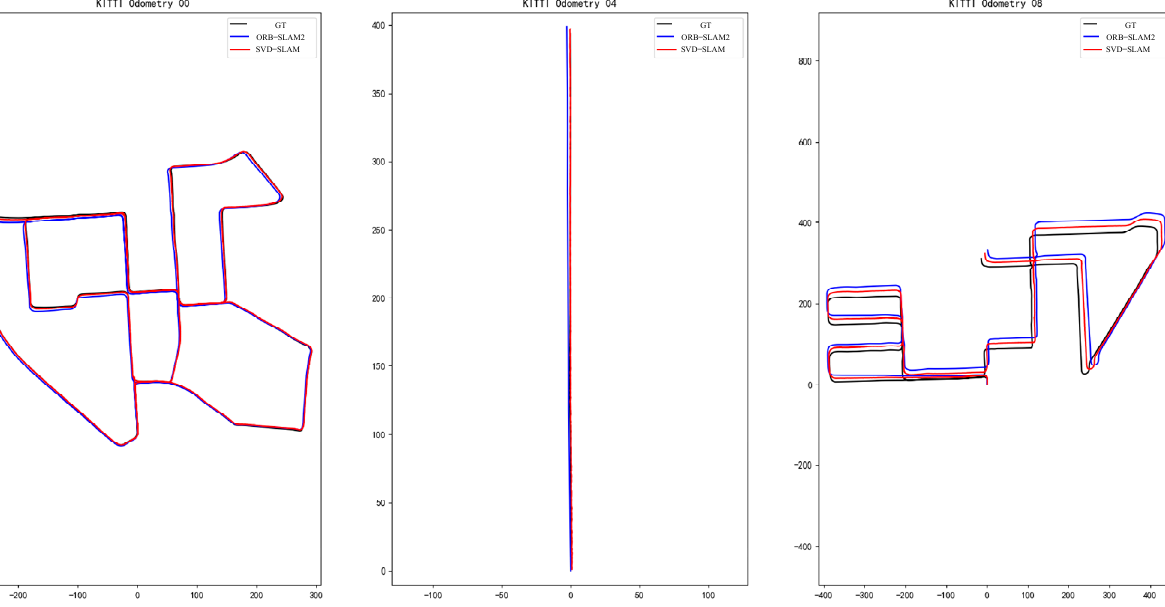
try. The outcomes are presented in Tables 2 and 3, where RMSE represents the root mean square error, Mean represents the mean error, and Std represents the standard deviation. Table 2. Comparison of absolute trajectory error Table 2. Comparison of absolute trajectory error (ATE).